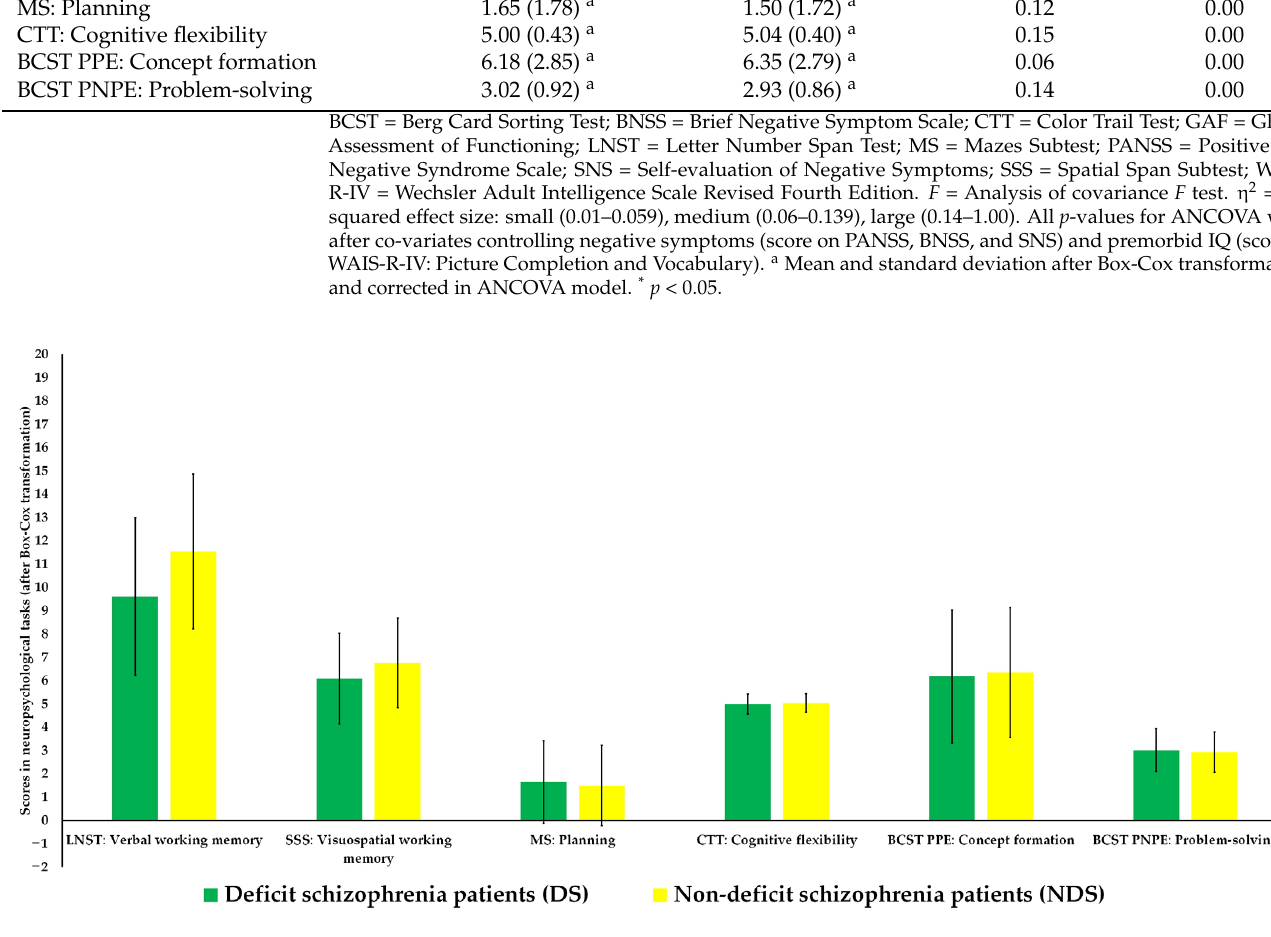
Table 4. Relationship between clinical factors, psychopathological symptoms, and different aspects of executive functions in the two patient groups.